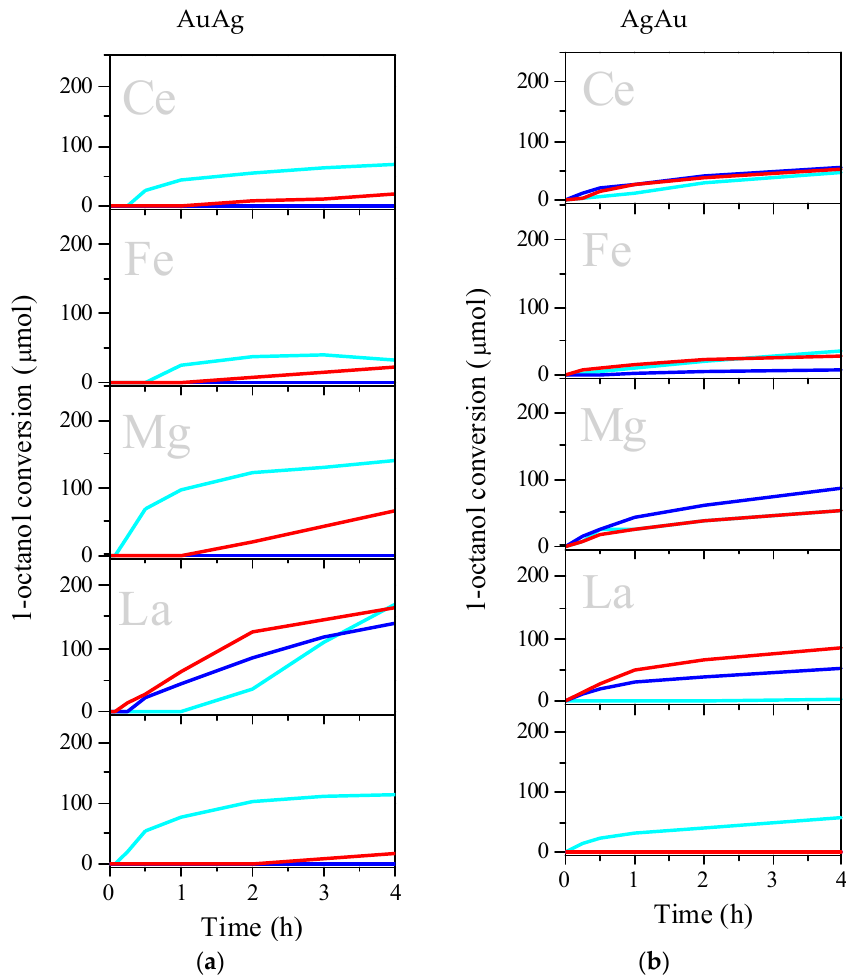
Figure 6. Effect of the metal deposition order on catalytic activity in 1 ‐ octanol oxidation: AuAg/M/TiO 2 ( a ) and AgAu/M/TiO 2 ( b ) for as prepared (light blue), H 2 ‐ pretreated (blue) and O 2 – pretreated (red) samples. Reaction conditions: 0.1 M of 1 ‐ octanol in n ‐ heptane; T = 80 °C; molar ratio octanol/Au = 100; no base added. Some previously reported results ( a ) are included for comparison, reprinted from [44] (copyright 2017), with permission from EUREKA SCIENCE.